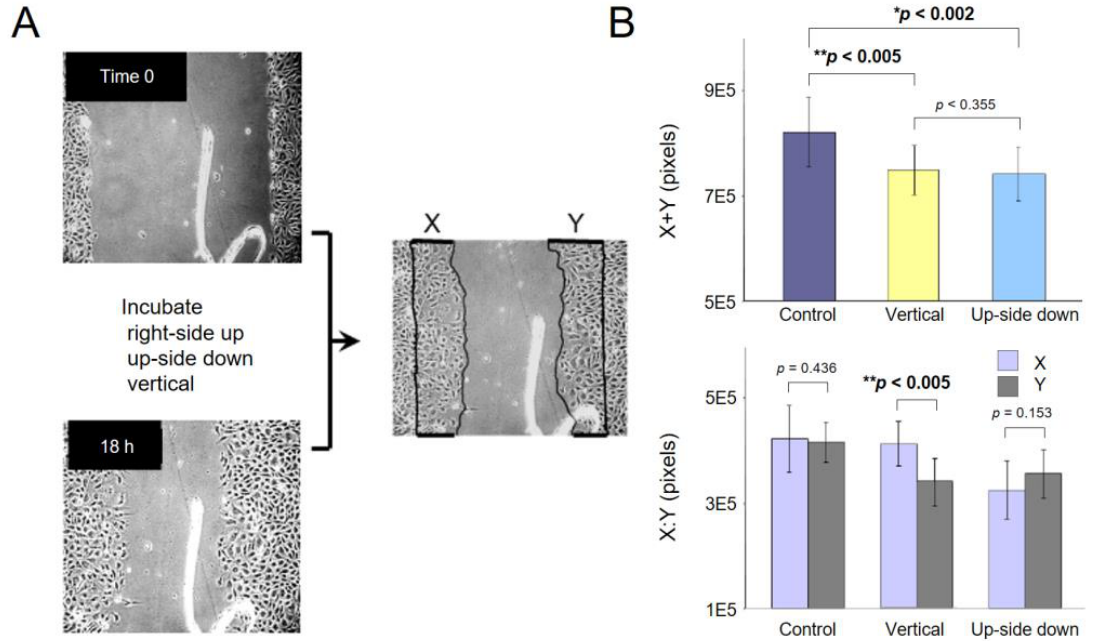
Figure 6. Slower wound closure in upside-down cultures. ( A ) Graphic outline of the wound healing assay. It also shows how the X and Y areas were defined. ( B ) Quantification of wound closure. p -values were calculated by t -test. These assays were repeated independently five times.